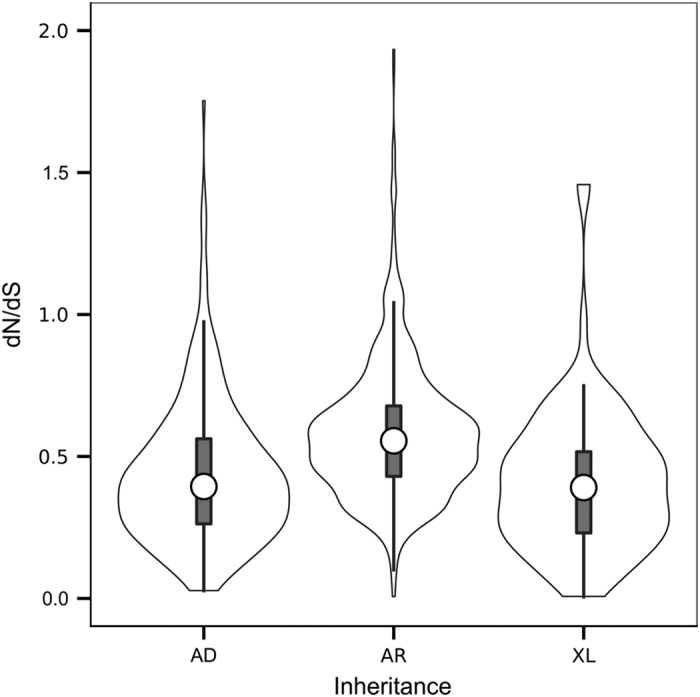
Missense depletion of genes by disease inheritance pattern. Violin plots of dN/dS for disease genes by inheritance annotation (OMIM and Orphanet). AD, autosomal dominant; AR, autosomal recessive, XL, X-linked. P<2.2e−16, Kruskal–Wallis rank sum test.